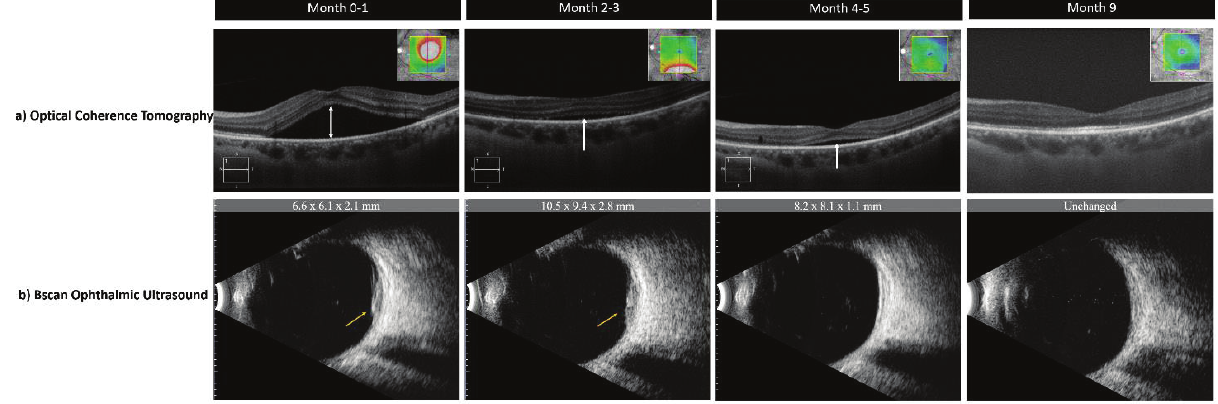
Figure 2. (a) Optical coherence tomography showing resolving subretinal fluid and flattening of retina. (b) Bscan ophthalmic ultrasound showing regression of metastatic